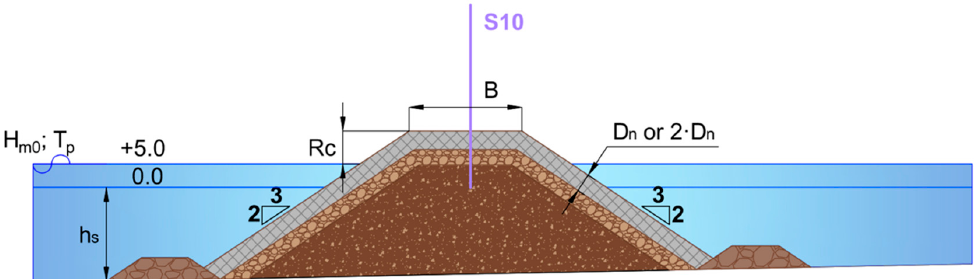
Figure 2. Cross-section of the tested mound breakwater model. Dimensions in m. Table 2. Characteristics of the materials used during the physical tests. Material